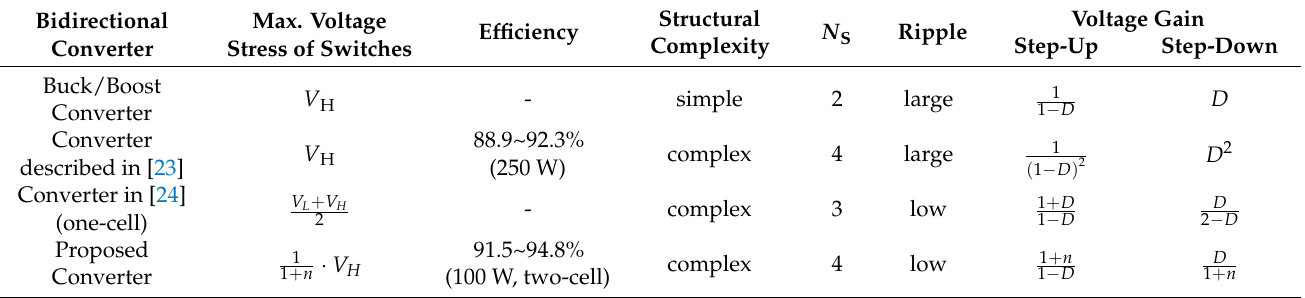
Table 1. Characteristic comparison of the proposed converter with its main